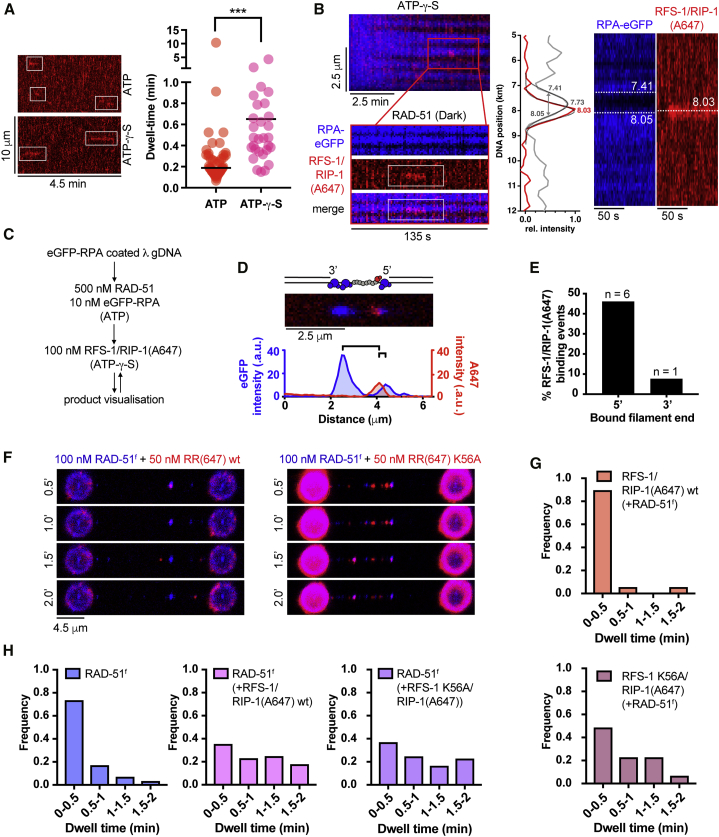
Transient engagement of RFS-1/RIP-1 with the 5′ filament ends is mediated by ATPase activity(A) Representative kymographs of dwelling single RFS-1/RIP-1(A647) (2.5 nM) complexes on RPA-eGFP coated ssDNA in the presence of 500 nM RAD-51 and ATP or ATP-γ-S (left panel). Quantification of experiment shown in left panel, for ATP (n = 47 binding events) and ATP-γ-S (n = 29 binding events). Black line represents median. p < 0.0001. Mann-Whitney test (right panel).(B) Representative traces of single RFS-1/RIP-1(A647) complexes binding to RAD-51 filaments in ATP-γ-S. RPA-eGFP shown in blue, RAD-51 dark, RFS-1/RIP-1(A647) red. Quantification of the RFS-1/RIP-1(A647) end binding using custom position analysis algorithm. 2D scan showing RFS-1/RIP-1(A647) (red channel) binding to the RAD-51 filament (dark, blue channel) in the presence of RPA-eGFP (blue channel). To obtain the exact location of the RAD-51 paralog with respect to the RAD-51 filament, the center of the filament is resolved first by fitting the reversed eGFP intensity (gray peak). Grey arrow, representing the peak’s width, marks the filament’s edges. Gaussian fit of the RFS-1/RIP-1(A647) intensity (red peak, red channel) indicates that the paralog binds to the periphery of the RAD-51 filament.(C) Protocol designed to visualize RFS-1/RIP-1(A647) binding to RAD-51 filaments grown on gapped λ DNA.(D) 2D scan of representative RAD-51-DNA complex obtained using protocol described in (C). Proximity of A647 signal maximum to eGFP signal maximum on either 3′ or 5′ RAD-51 filament border was used to estimate the 3′ or 5′ filament end binding polarity.(E) Quantification of filament 5′ or 3′ end binding frequencies by RFS-1/RIP-1(A647) (n = 13 binding events). Remainder of RFS-1/RIP-1(A647) binding events observed in the experiment was binding to “dark” RAD-51 filaments forming on extended dsDNA portion of the gapped molecule. No binding of RFS-1/RIP-1(A647) to RAD-51-free RPA-eGFP-coated ssDNA was observed.(F) Representative fluorescence images taken after RAD-51f+RFS-1/RIP-1(A647) or RAD-51f+RFS-1 K56A/RIP-1(A647) incubation-detection cycles with the same ssDNA construct; cumulative incubation time is indicated. RAD-51f signal shown in blue. RFS-1/RIP-1(A647) signal shown in red.(G) Histograms of dwell times of WT RFS-1/RIP-1(A647) (n = 19 clusters; top) or RFS-1 K56A/RIP-1(A647) (n = 31 clusters; bottom) in the presence of RAD-51f. Number of dwell-time categories was adjusted to accommodate lower stability of bare ssDNA in the presence of RFS-1 K56A/RIP-1(A647).(H) Histograms of dwell times of RAD-51f alone (n = 160 clusters; left) or in the presence of RFS-1/RIP-1(A647) WT (n = 57 clusters; middle), or dwell times of RAD-51f in the presence of RFS-1 K56A/RIP-1(A647) (n = 49 clusters; right).